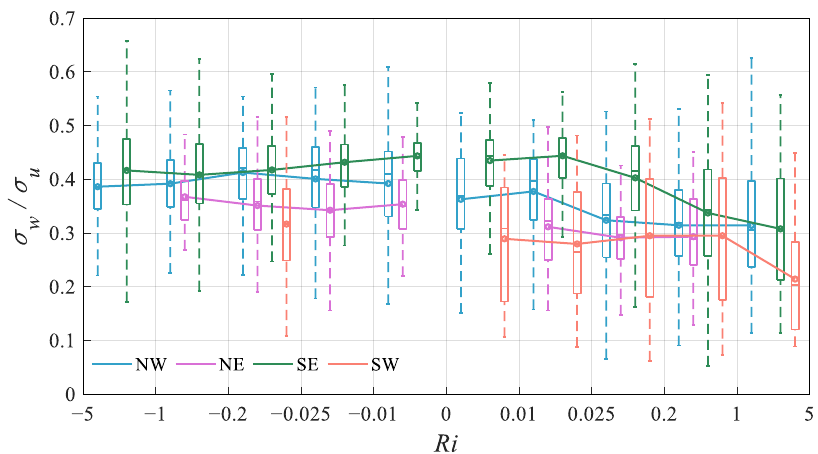
Figure 8. The dependence of the turbulent aspect ratio A r on stability Ri in different wind directions. The box plots represent the statistic of A r in different Ri intervals. For a certain box, the bottom is the lower quartile Q1, the top is the upper quartile Q3, the horizontal line in the middle of the box is the median Q2 and the open circle is the average; the top of the whisker is O3 + 1.5IQR, and the bottom is Q1 − 1.5IQR, where IQR is the interquartile range IQR = Q3 − Q1.